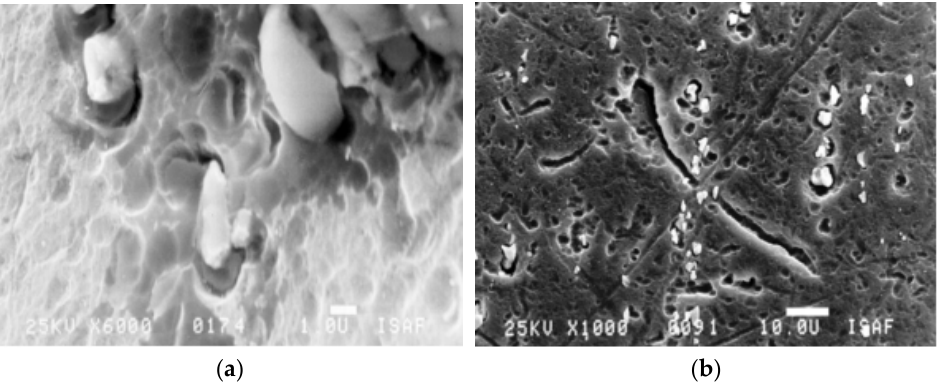
Figure 14. SEM results for the test object after being loaded with compressive tension,  a =1%, N = 66. ( a ) Particle movement; ( b ) microcrack. ( a ) Particle movement; ( b ) microcrack.